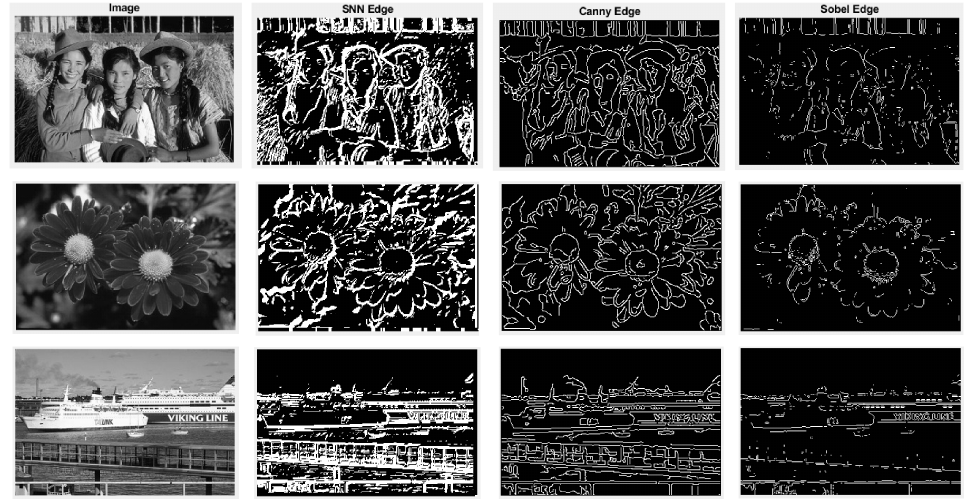
Figure 4. Examples images along with the comparison of edges generated by SNN, Canny and Sobel edge detectors.